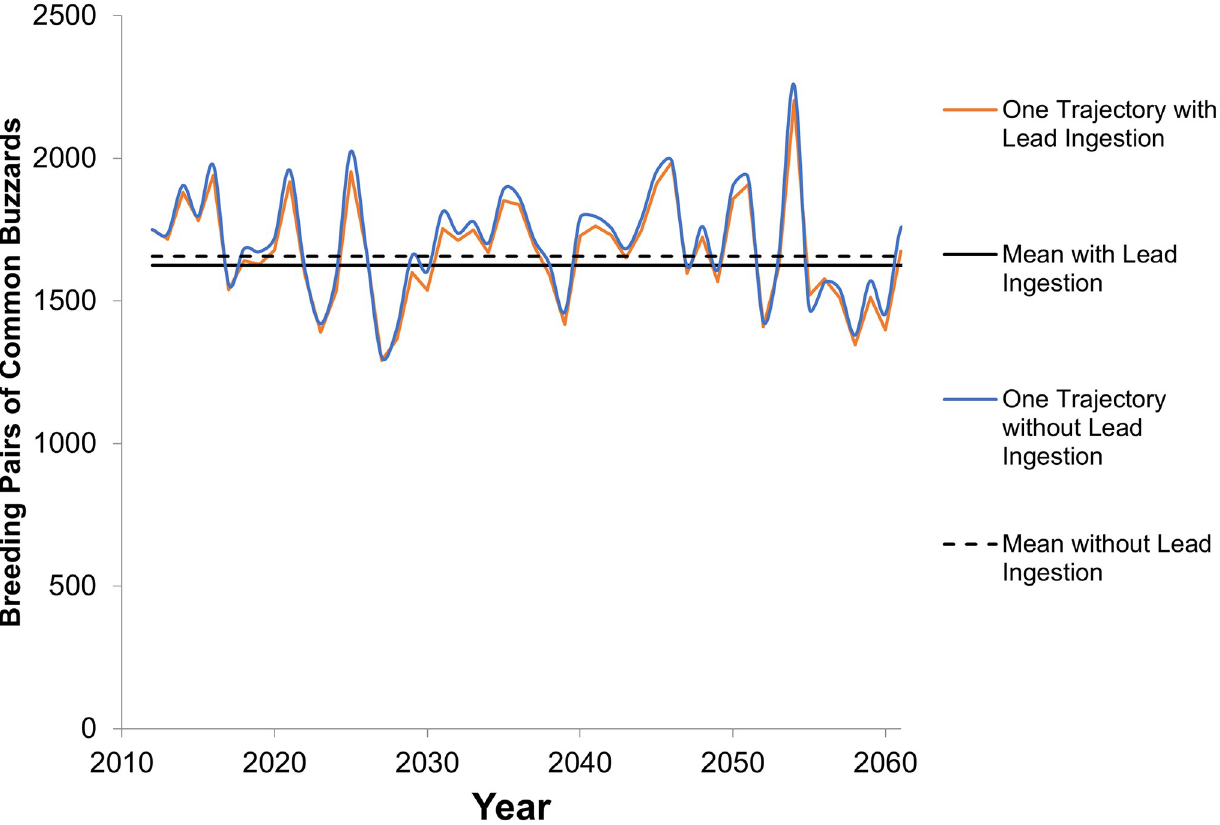
Fig 4. Modeled population trends for common buzzard with and without lead shot and bullet ingestion. Shown with reproductive effects. In addition to the mean, an example iteration of one of the 10,000 runs is shown to demonstrate the trend variability.